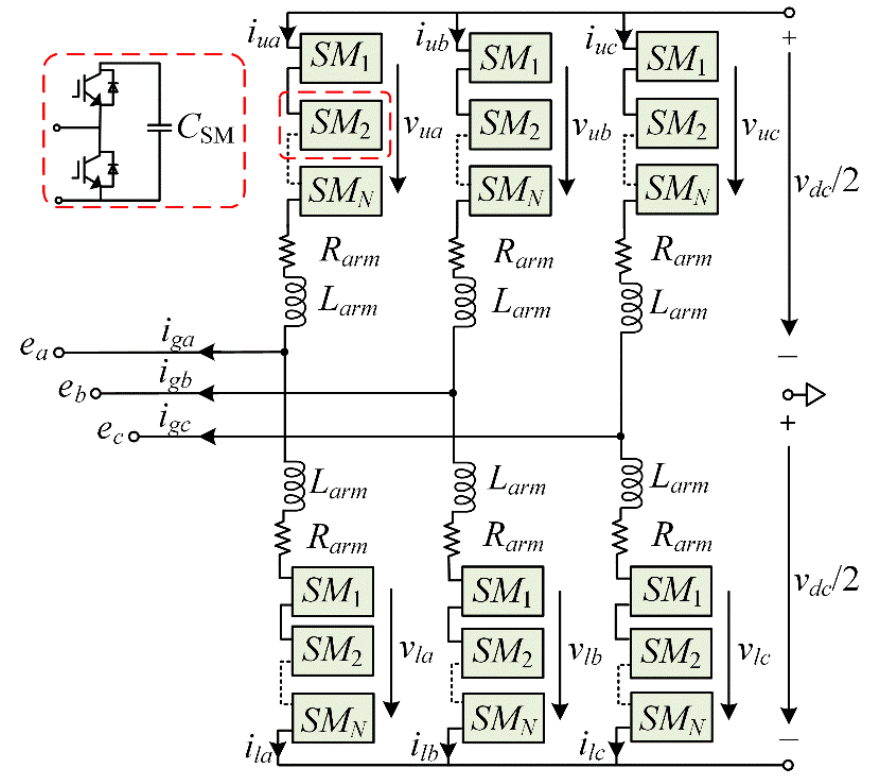
Figure 1. Topology of the modular multilevel converter.